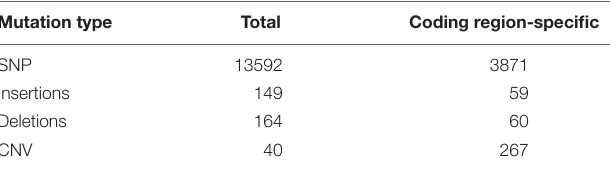
TABLE 4 | Identified mutations in the genome of Afs35 when compared to the genome of A1163 (SNP, single nucleotide polymorphism; CNV, copy number